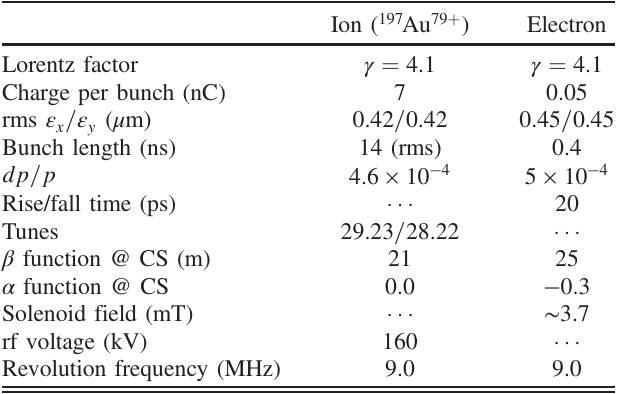
TABLE III. Initial beam parameters in the experiment.